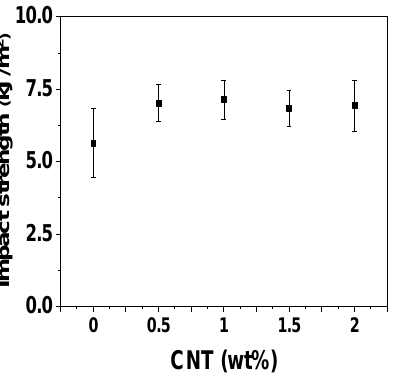
Figure 4. Izod impact strengths of POM/CNT nanocomposites.